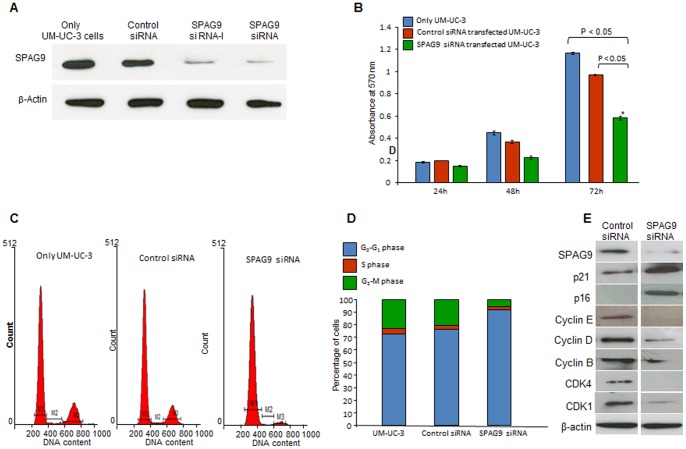

SPAG9 Silencing and its effect on cellular proliferation and cell cycle.(A) Western blot depicts ablation of SPAG9 protein in UM-UC-3 cells transfected with SPAG9 siRNA. β-Actin was used as a control. (B) Knockdown of SPAG9 by siRNA inhibited cell growth in UM-UC-3 cells in vitro determined by MTT assay. (C) Silencing of SPAG9 expression arrested cell cycle progression in G0–G1 phase in SPAG9 siRNA transfected cells as compared with only cells or scrambled siRNA transfected cells. (D) Histogram analysis confirmed that in SPAG9 siRNA transfected cells accumulated in G0–G1 phase. (E) Western blot analysis of cell cycle molecules in SPAG9 ablated UM-UC-3 cells depicted up-regulation of CDK inhibitors including p21 and p16. The up-regulation of p21 and p16 was preceded by down-regulation of cyclin E, cyclin D, cyclin B, CDK4 and CDK1. β-Actin was used as an internal loading control. [M1- G0–G1 phase; M2- S phase and M3- G2-M phase].